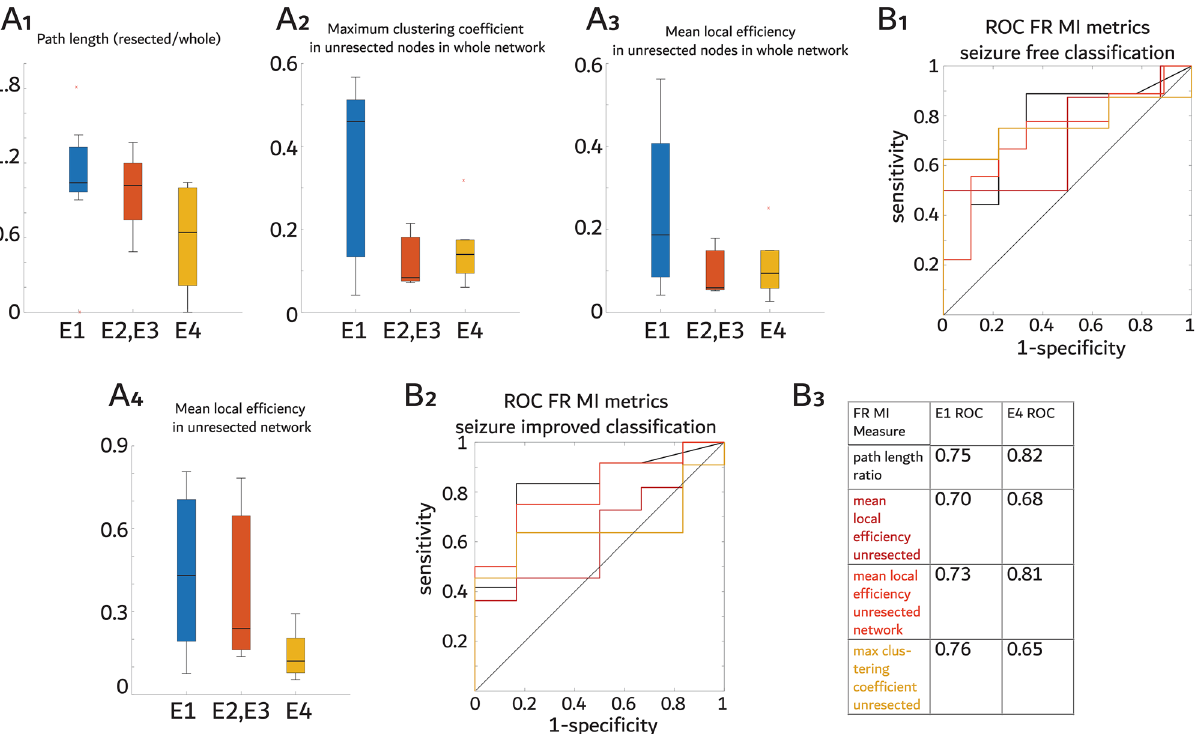
Figure 5. Graph theoretical metrics of the fast ripple (FR) mutual information (MI) temporal correlational network relative to the margins of the resection predict post-operative seizure outcome. ( A ) Box plots of the FR MI graph theoretical metrics stratified by post operative seizure outcome Engel (E) class. The FR MI mean characteristic path length resected ratio (A1) measured from communicating edges only in the resection margins divided by the path length measured from the whole FR MI network (Spearman rank correlation, p < 0.05). The maximum clustering coefficient value (A2) among the unresected nodes calculated from the whole FR MI network prior to resection (Spearman, p > 0.05). The mean local efficiency value (A3) as in A2 (Spearman, p > 0.05). The mean local efficiency value from the FR MI network characterized after resection (Spearman p < 0.05, A4). ( B ) Receiver operating characteristic curves (ROC) of these FR MI graph theoretical metrics for predicting seizure free (E1) outcome (B1) or seizure improved (E1-3) outcome (B2). The color-coded legend for the ROC curves and the corresponding area under the ROC curve values (B3).